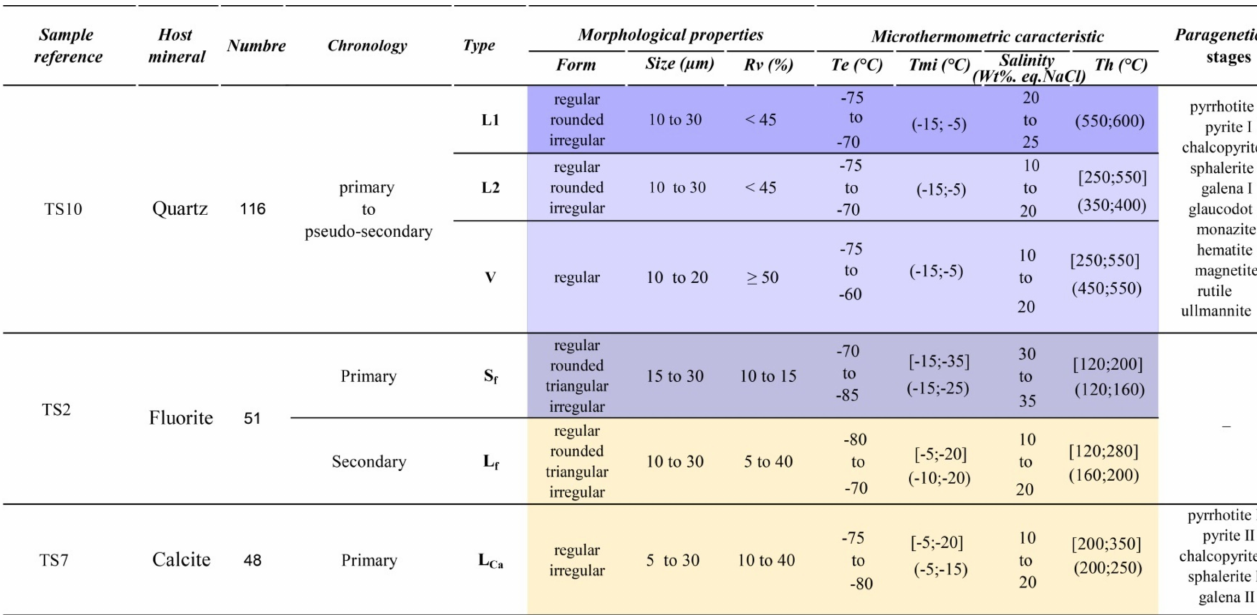
Figure 19. Summary of the fluid inclusions of the NNE-A deposit. Rv: Ratio vapour, Te: Eutectic, Tmi: melting temperature of the